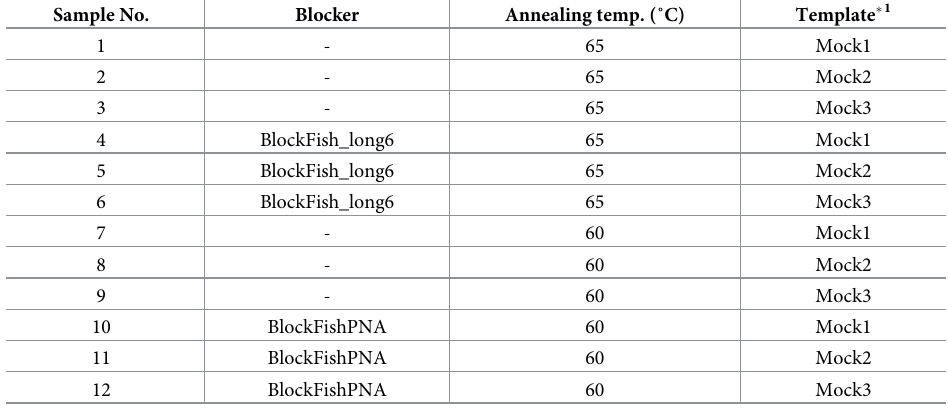
� 1 : Mock samples described in Table